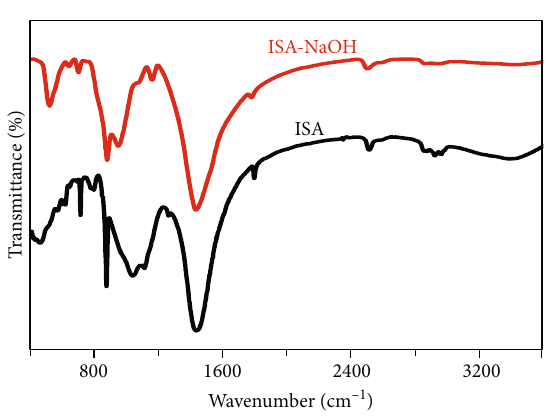
Figure 2: FTIR spectra of ISA and sintered product.